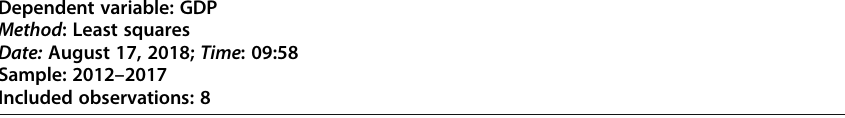
Table 8 Building the model with deposits, remittances, and loans as